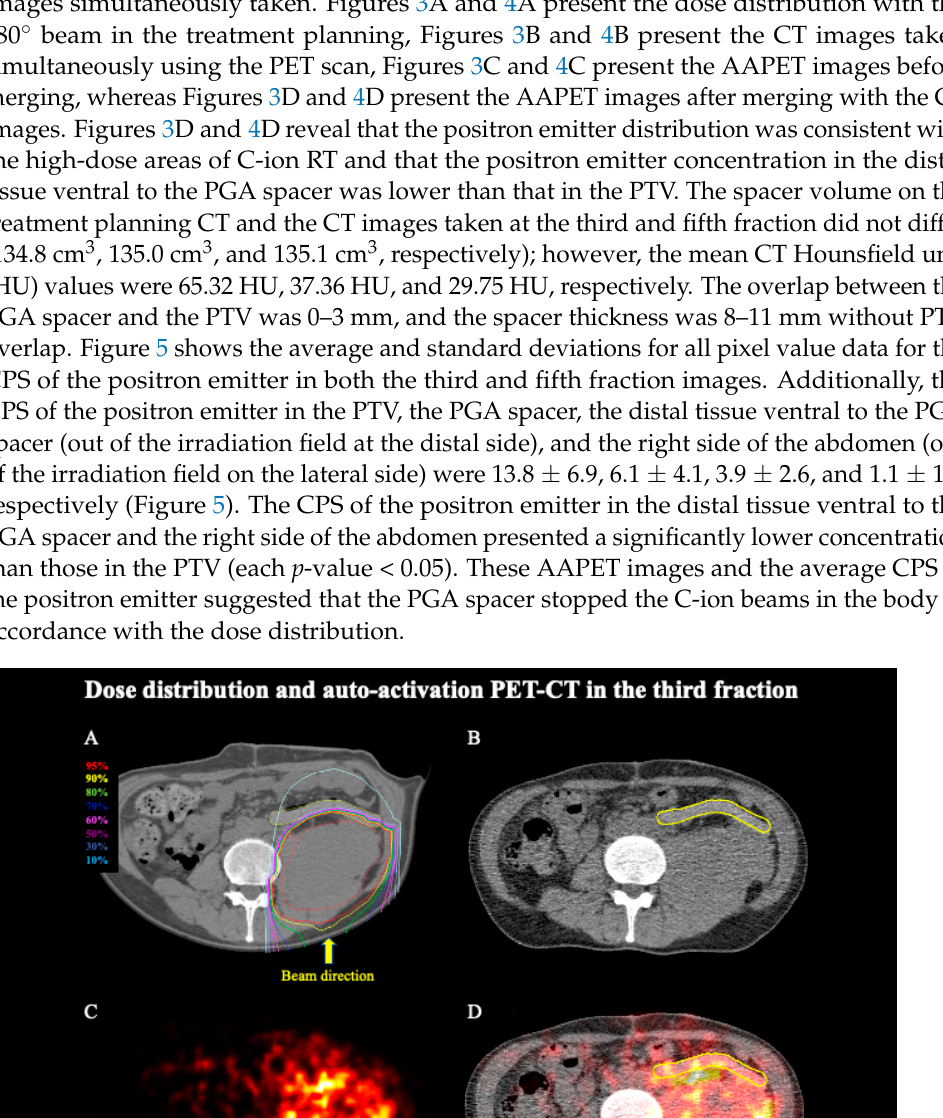
Figure 4. Dose distribution of C-ion RT and AAPET images with a 180° beam in the fifth fraction. ( A ) Dose distribution of C-ion RT with 180° beam. The area within the red outline is the tumor. Highlighted are the 95% (red), 90% (yellow), 80% (green), 70% (deep blue), 60% (magenta), 50% (purple), 30% (blue), and 10% (light blue) isodose curves (100% was 4.4 Gy (RBE)). ( B ) CT image simultaneously taken with the PET scan. The area within the yellow outline is the spacer. ( C ) AAPET image. ( D ) Positron emitter distributions obtained by merged CT and AAPET images. The area within the yellow outline is the spacer.